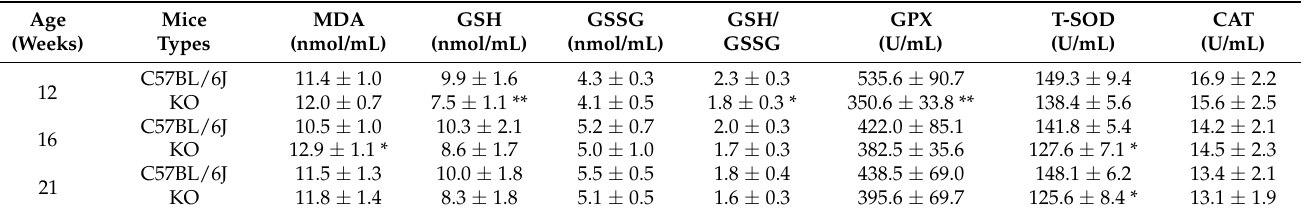
Table 1. Effects of SELENOF knockout on serum oxidative stress parameters in mice of different ages.